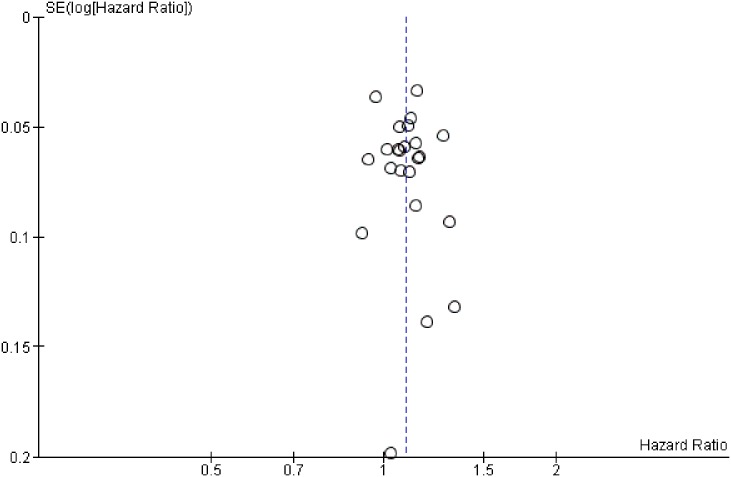
Funnel plot for exposure to secondhand tobacco smoke and risk of under-five mortality.The plot’s the x-axis is the hazard ratio for each country while the y-axis is the standard error of the hazard ratio (random effects model). The countries’ (cycles) pooled effect estimate is indicated by the dotted vertical line.